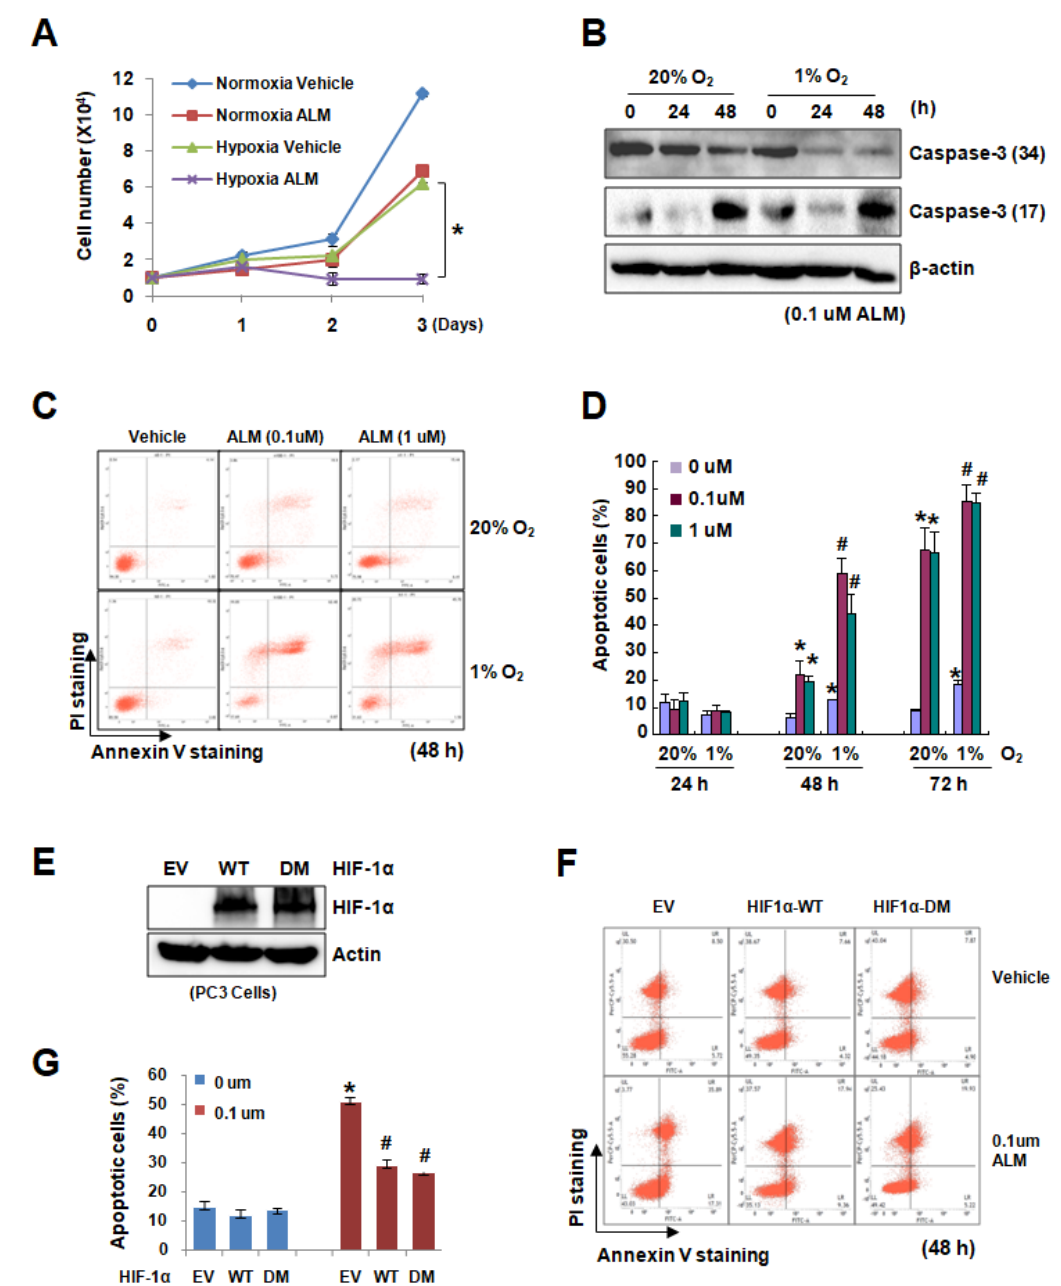
Figure 3. ALM induces HIF-1 α -dependent apoptosis in PC3 cells. ( A ) Cell growth curve of PC3 cells exposed to vehicle or 30 nM ALM for 3 days under normoxia and hypoxia. ( B ) PC3 cells were treated with ALM for 24 h and 48 h at 0.1 µ M under normoxia and hypoxia, followed by Western blot for caspase-3. ( C , D ) PC3 cells were treated with ALM for 24 h, 48 h, 72 h at 0.1 µ M and 1 µ M under normoxia and hypoxia, followed by staining with FITC-conjugated Annexin V and PI for flow cytometric analysis. Representative result of 48 h was presented as Figure 3C ( C ). The flow cytometry profile represents Annexin V-FITC staining in X axis and PI in Y axis. The number represents